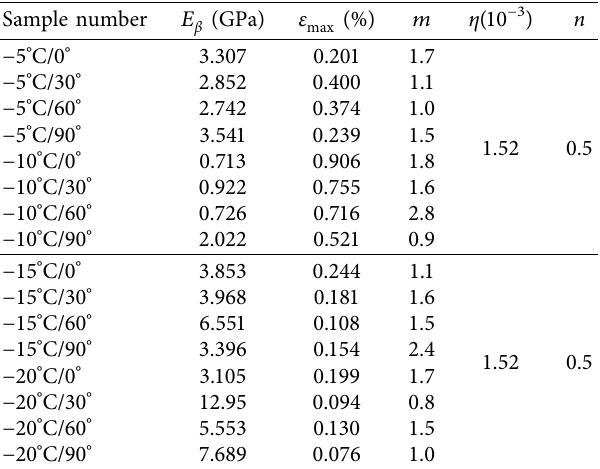
Table 2: Constitutive